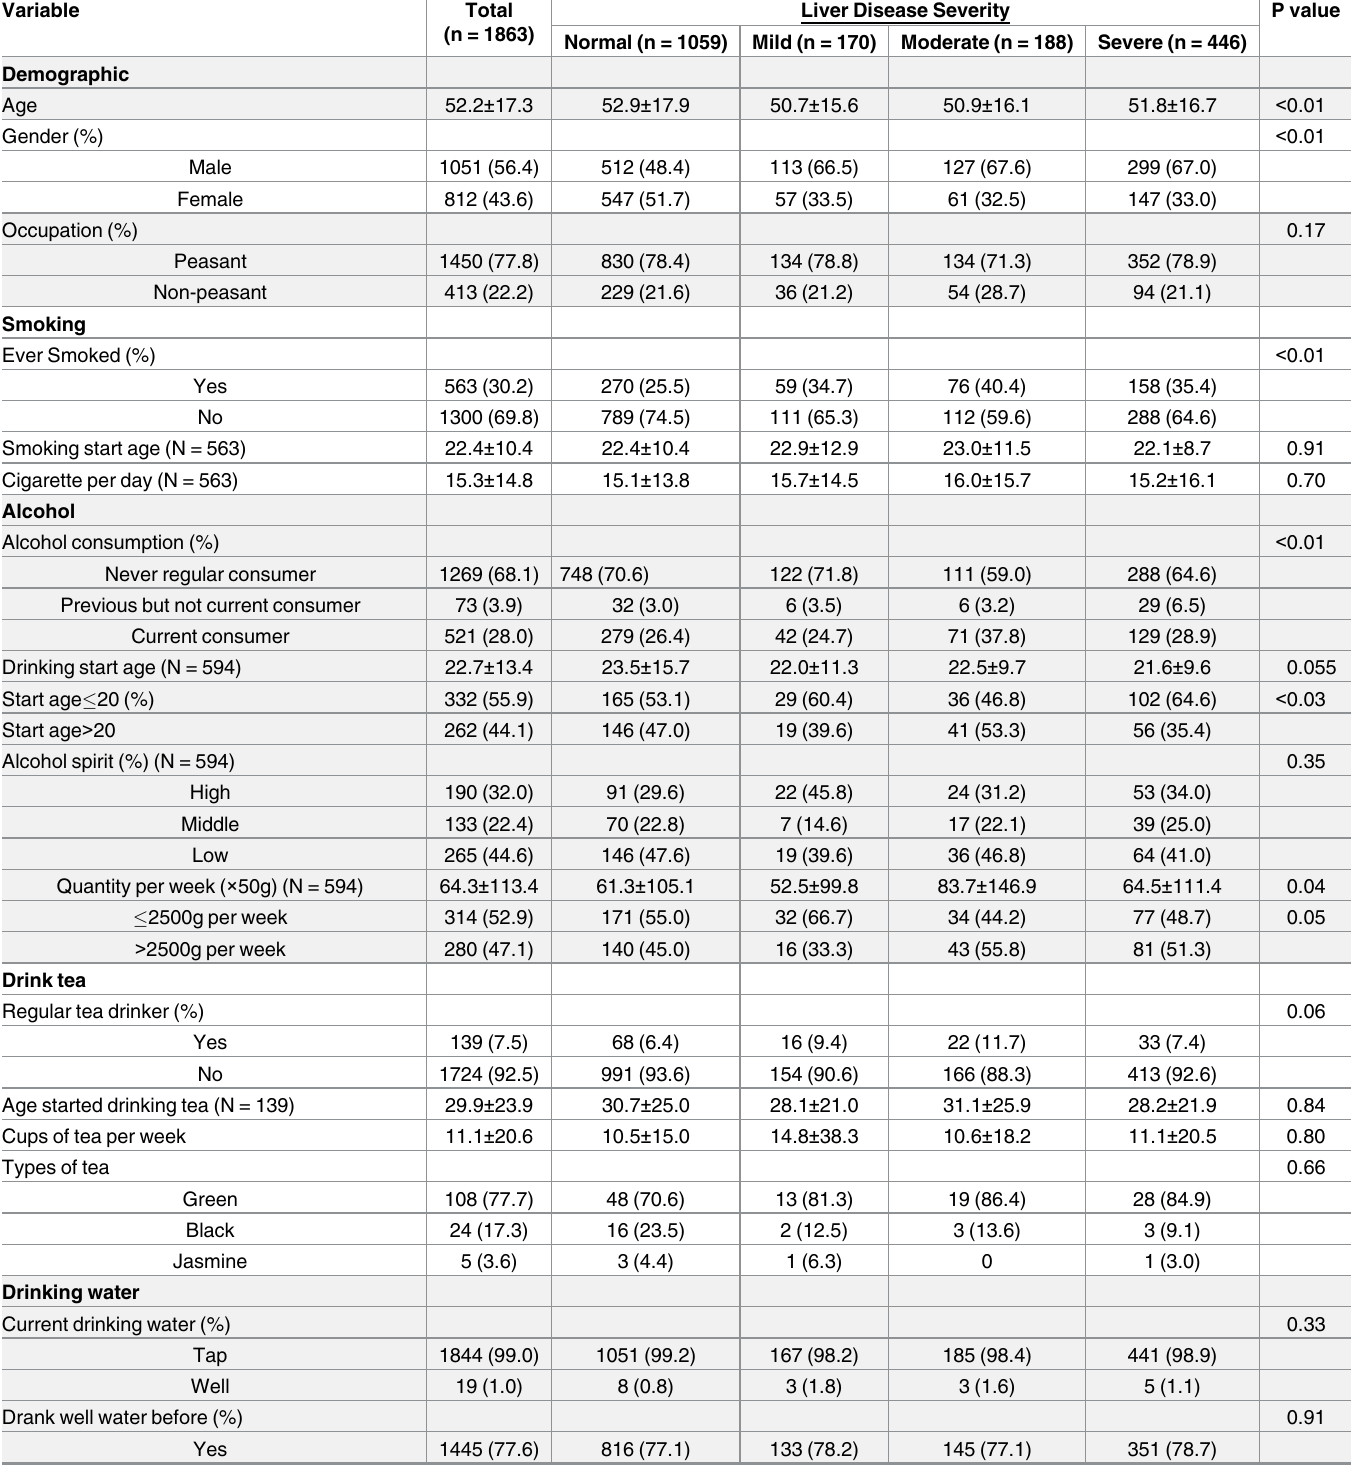
Table 1. Individual characteristics and liver disease severityamong participants in Haimen City cohort in